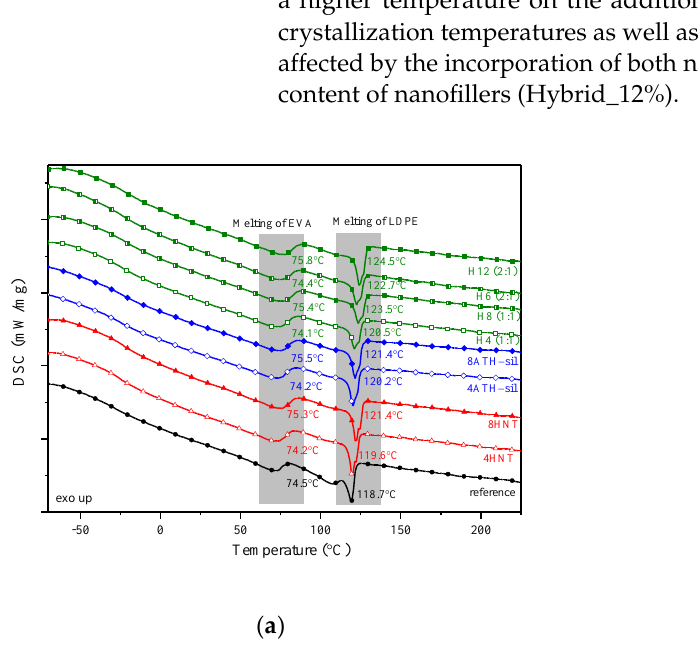
Figure 6. Differential scanning calorimetry (DSC) thermograms recorded during ( a ) 2nd heating and ( b ) cooling for the series of compositions containing HNTs and/or ATH–sil. Table 3. Thermal properties of EVA/LDPE (reference), and prepared compositions.